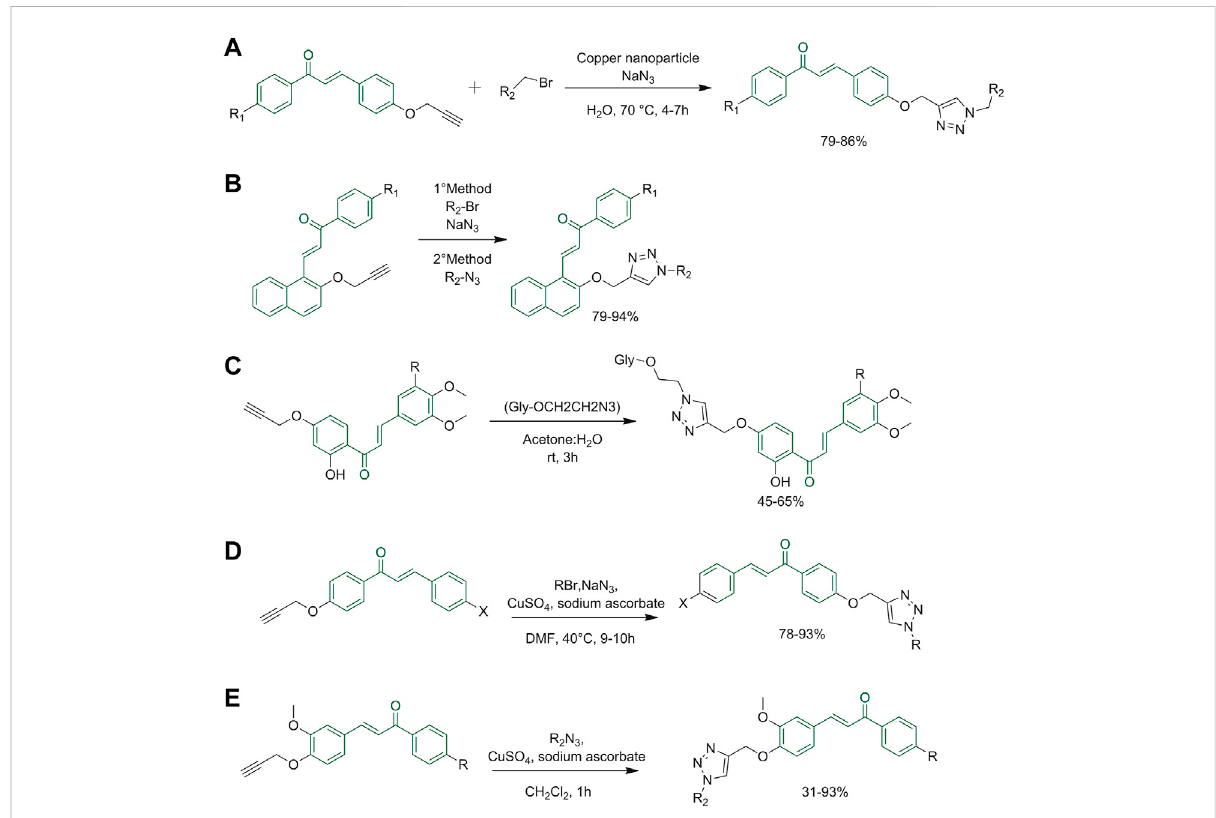
FIGURE 9 (A) Synthesis of chalcone derivatives starting with 4- O -propargylated benzaldehyde; (B) synthesis of 1,2,3-triazole derivatives using propargylated chalcones and azides; (C) click reaction copper (I) -catalyzed azide-alkyne cycloaddition (CuCAA) to obtain fl avonoid glycosides with triazole moieties; (D) triazole synthesis through one-pot click reaction; (E) triazole synthesis through one pot click reaction catalyzed by CuSO 4 and